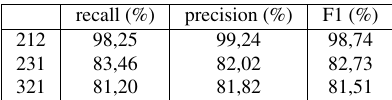
Table 3. Spain: Evaluation metrics (opt+NDVI+text+topo).